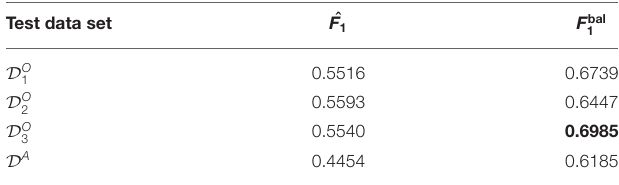
TABLE 3 | The results of the intra-set study (Experiment A): ˆ F 1 and F 1 scores obtained from training a ResNet-34 on each data set separately and testing it on data from the same data set.